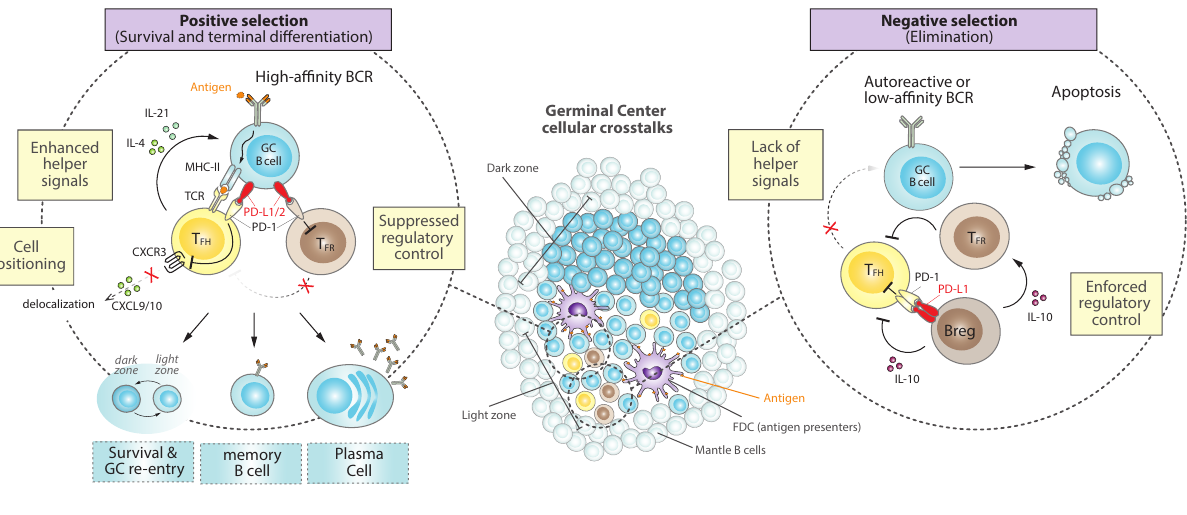
Figure 1. Cellular crosstalks and the PD-1/PD-L1 axis during normal GC reactions. Surrounded by a mantle zone, GCs expand as a result of the fast proliferation of antigen-specific B cells that are densely packed to form a dark zone, before moving into a light zone containing FDCs and other regulatory cells that orchestrate